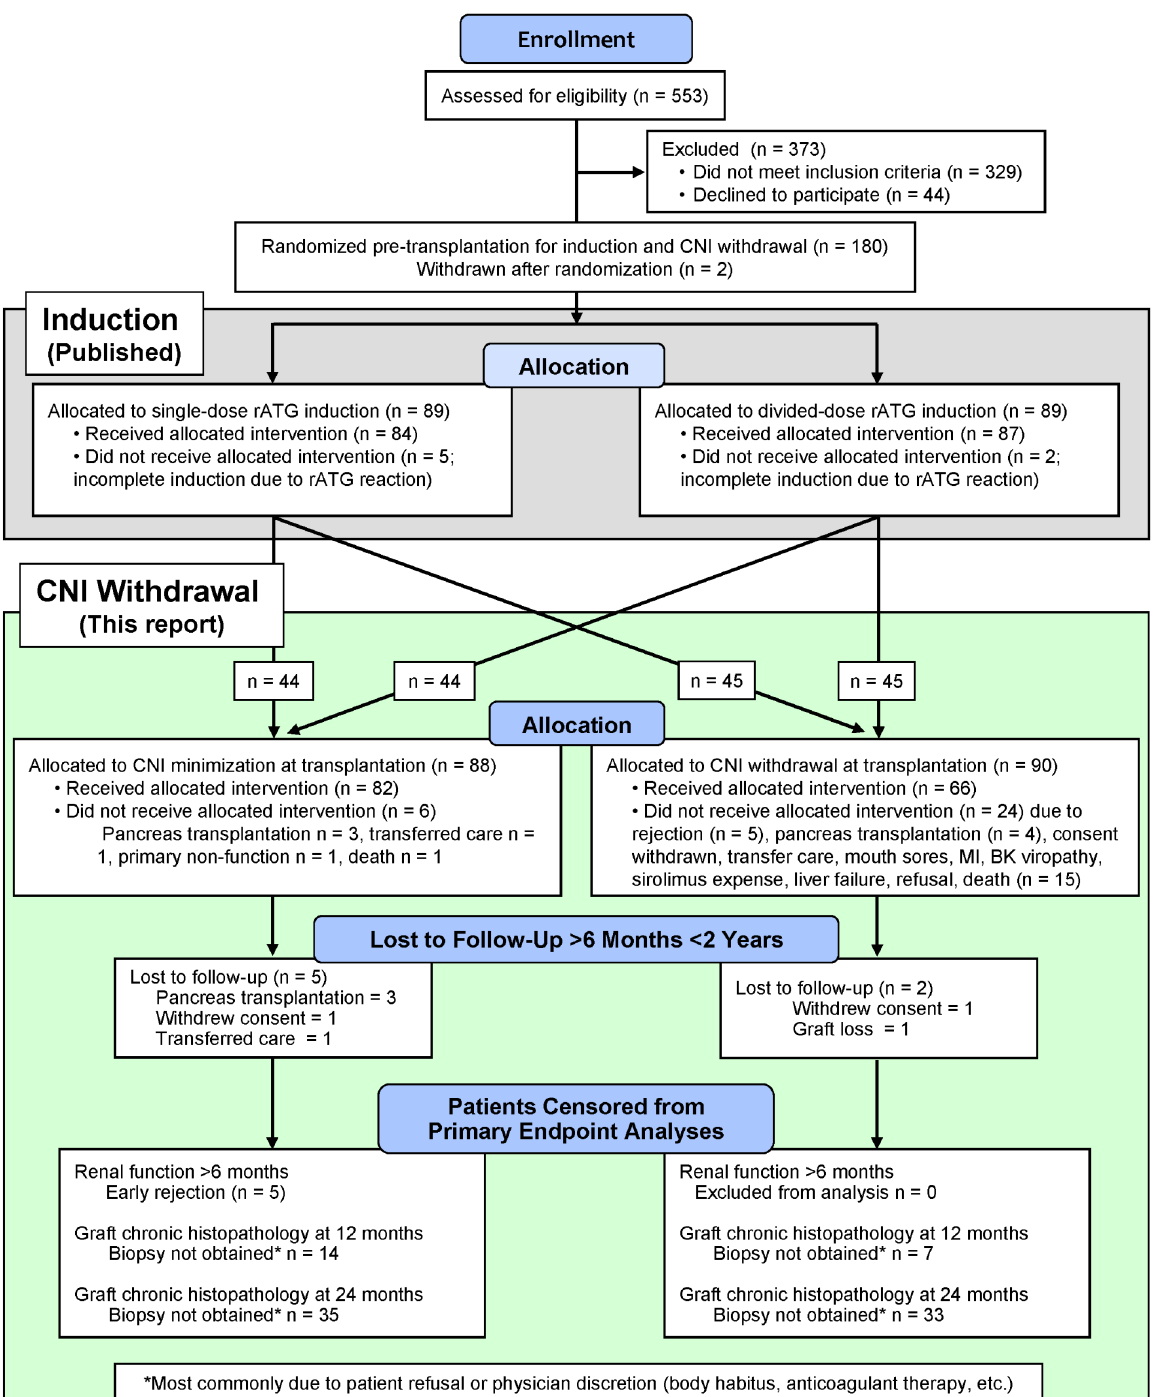
Fig 1. CONSORT flow diagram of randomized 2x2 trial of rATG induction dosing and delayed CNI withdrawal [52]. The study statisticians provided computer-generated randomized assignments in sequentially-numbered, sealed opaque envelopes opened after obtaining consent for trial participation. Randomization included stratification by race (Caucasian/Asian vs. non-Caucasian/Asian), donor type (living vs. deceased), and whether listed for eventual pancreas transplantation. Study patients were identified and enrolled by attending transplant physicians and study coordinators. The integrity of the treatment arm assignments made by this system was monitored and confirmed by the study statisticians. Two patients not meeting enrollment criteria were consented and randomized in error, but were identified before transplantation and removed from participation in the trial.